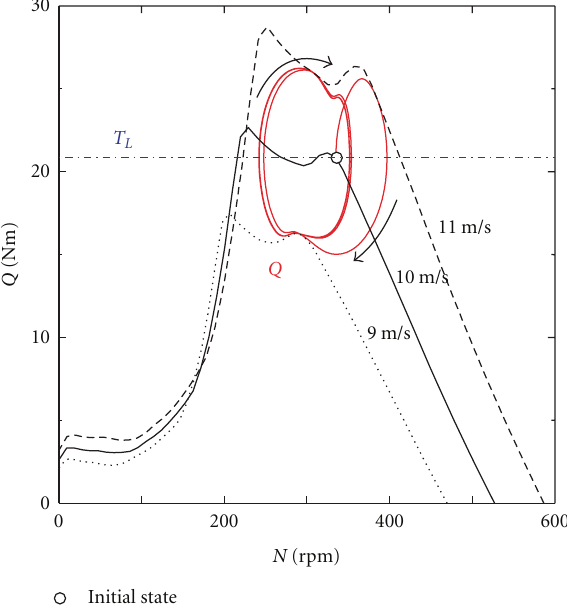
Figure 23: Locus of torque, Q , of pulsating wind in the case where V = 10 m/s, T = 16 s, and I = 5kgm 2 . Constant load torque is T L = 0 20.8Nm. Final average rotational speed is N ave = 299 . 4 rpm.